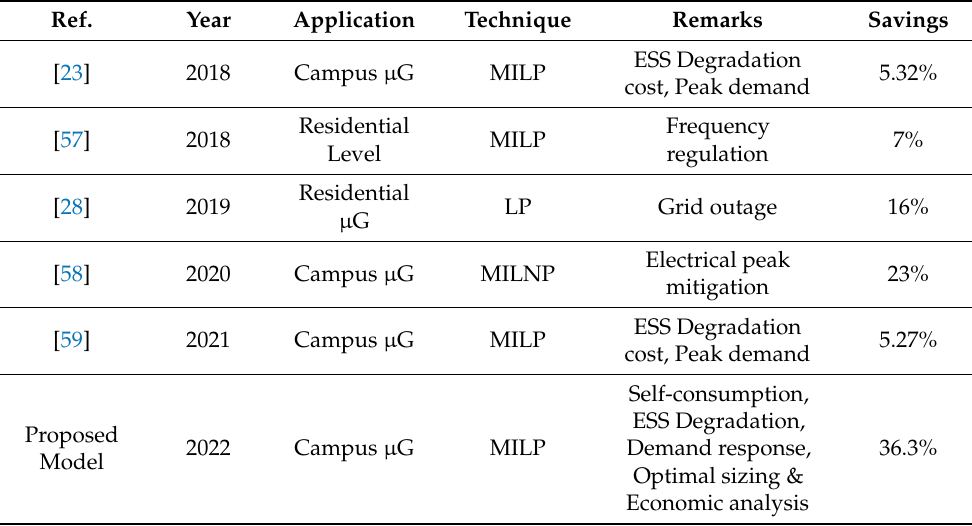
Table 4. Comparison of the existing works compared with the proposed method.